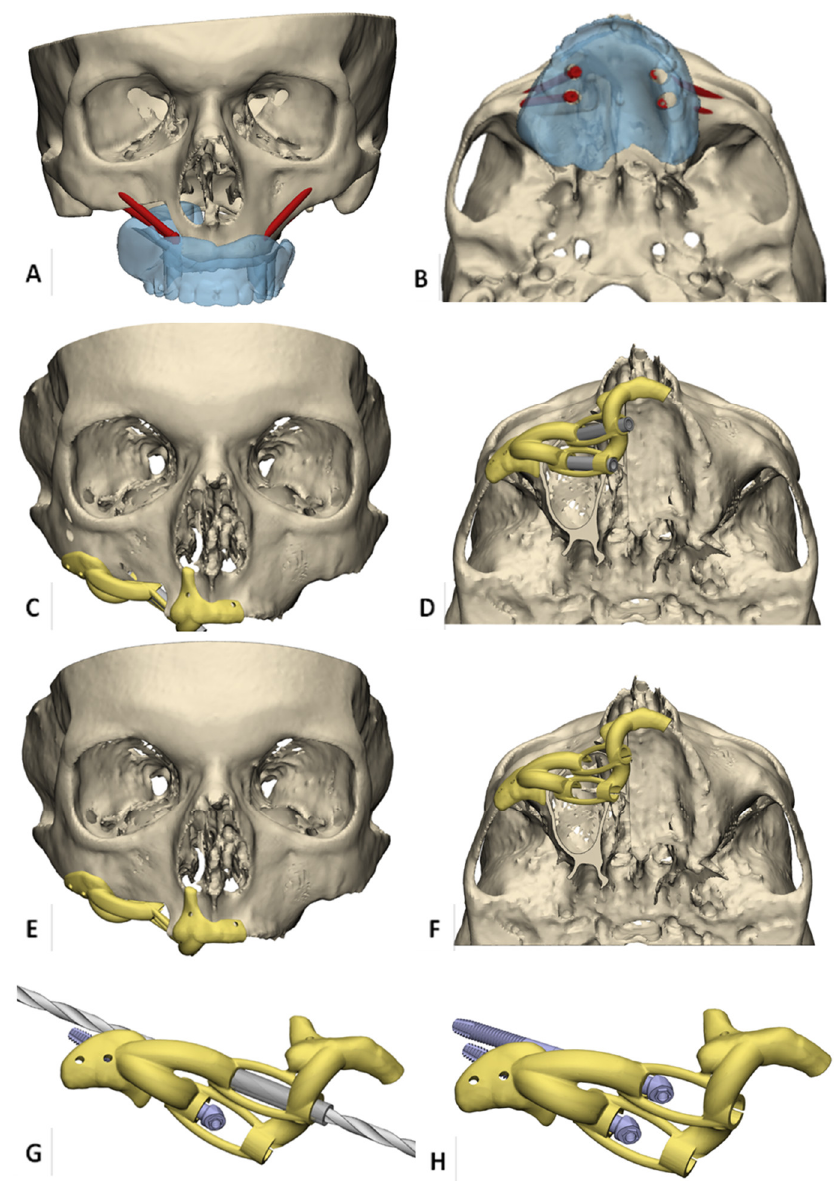
Figure 2. Overview of 3D VSP workflow for virtual zygomatic implant planning. ( A , B ) Virtual obturator prosthesis-driven zygomatic implant planning in an edentulous patient with right-sided maxillary resection planning. ( C , D ) Bone-supported zygomatic implant drill guide. Support is gained at alveolar ridge, nasal aperture, and zygomatic arch for stable positioning, and centered channels in the drill-guide enable insertion of stainless steel milled drill sleeves. ( E , F ) the length of the channels forms an integral depth stop for the zygomatic implants. ( G ) detailed view of drill guidance. ( H ) detailed view of zygomatic implants placed through the guide to enhance correct prosthetic head positions.